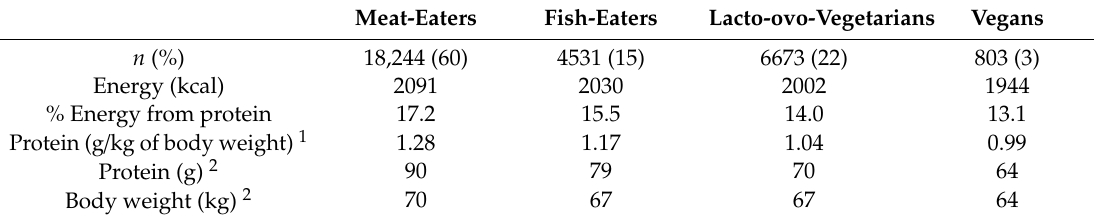
Table 1. Protein intake of vegetarians compared to meat-eaters in the EPIC-Oxford study, classified according to answers to questions on whether those involved ate any meat, fish, eggs, and dairy products. Data from Sobiecki et al. [5].